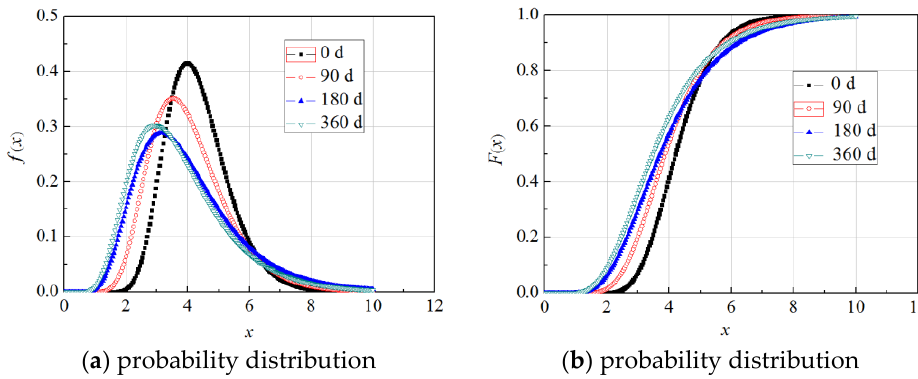
Figure 3. The probability distribution and cumulative distribution of typical specimens.